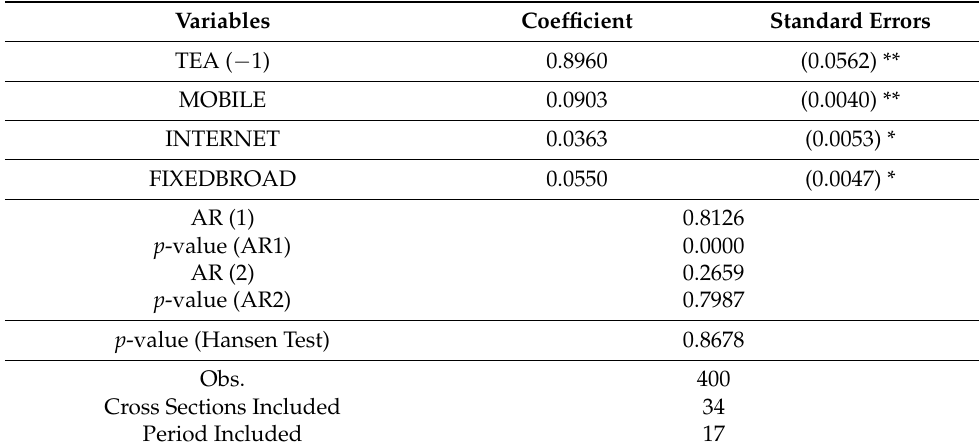
Table 4. Results of GMM Estimation. Dependent Variable: